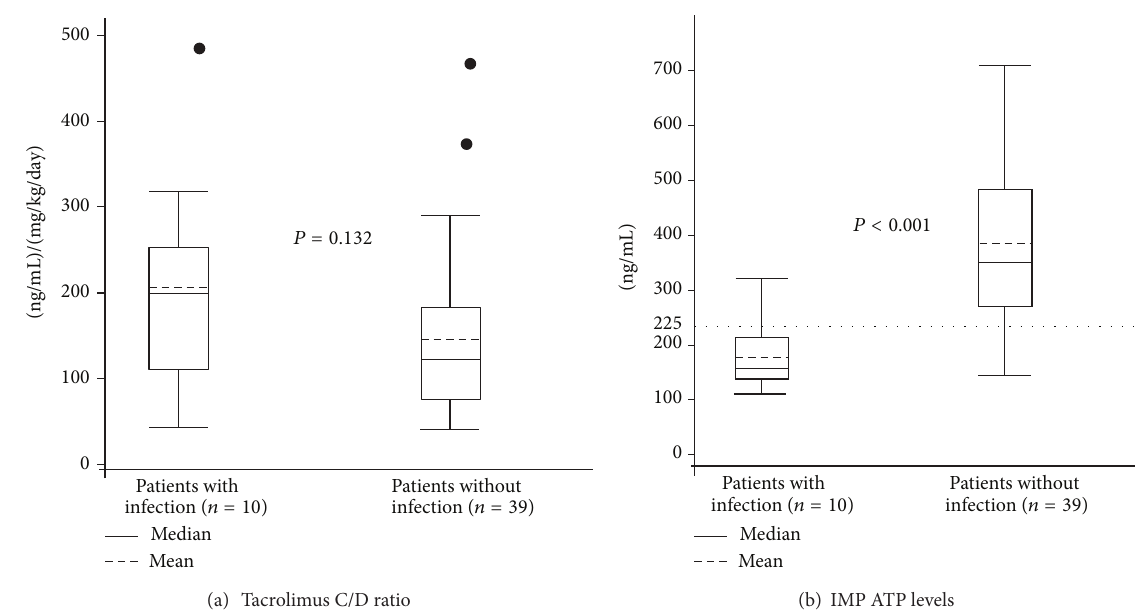
Figure 2: IMK ATP levels and tacrolimus C/D ratio in patients with or without infection. (a) The ATP was 218.4 ± 129.2 (range 112–312) ng/mL and 149.3 ± 99.1 (range 146–706) ng/mL, respectively. (b) The ATP was 185.5 (range 112–312) ng/mL and 350 (range 146–706) ng/mL,